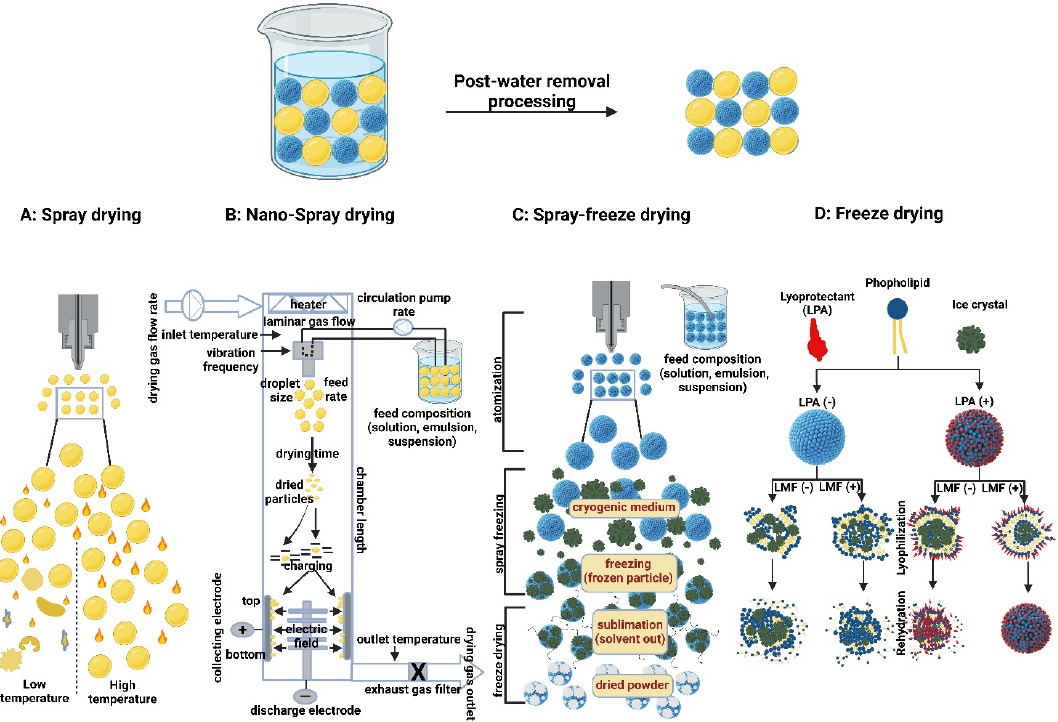
Figure 10. Post-water removal processing technologies for lipid bilayer vesicles (LPs and EVs): ( A ) Spray drying technology. ( B ) Nano-Spray Dryer B-90 HP (Büchi Labortechnik AG Switzerland) technology. ( C ) Spray-freeze drying technology. ( D ) Freeze-drying technology.